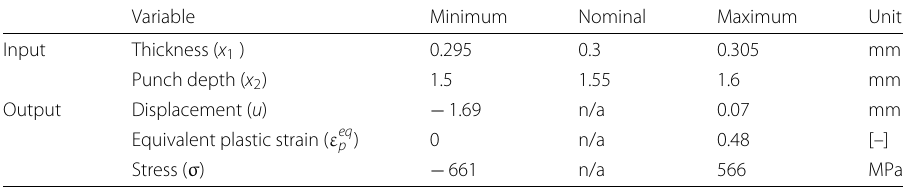
Table 3 Ranges and dimensions of the input and output of the industrial bending